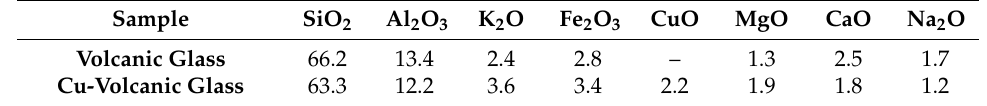
Table 1. Chemical composition of volcanic glass and Cu-volcanic glass (%).